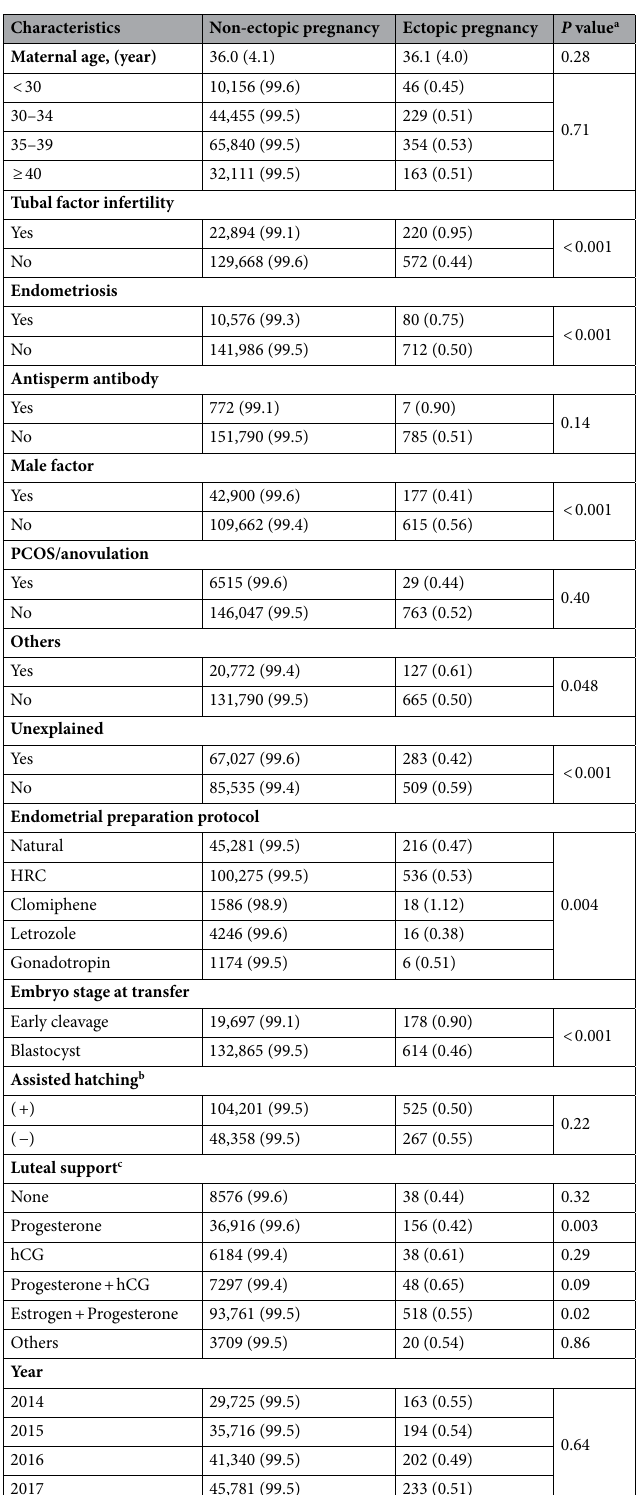
Table 1. Baseline characteristics of the sample population stratified by ectopic pregnancies. (n = 153,354). Data are presented as mean (SD) for continuous variables and n (%) for dichotomous variables. Percentages are presented in the rows for the purpose of comparison. hCG human chorionic gonadotropin, HRC hormone replacement cycle, PCOS polycystic ovarian syndrome. a P values were assessed with the use of the χ 2 or Student’s t test. b 3 cases were missing in the variable. c Multiple answers were